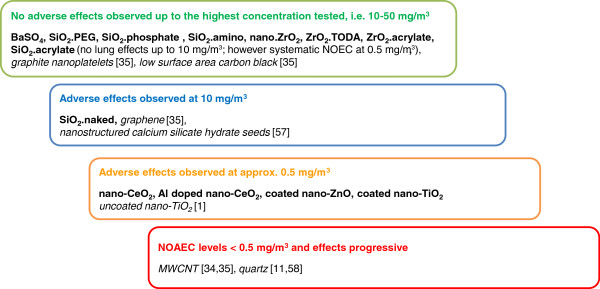
Ranking of nanomaterials according to their toxic potency. Names of substances presented in this paper are printed in bold. Names of substances assessed in other studies are printed in italics and the corresponding reference is provided [1,11,35,57,58].